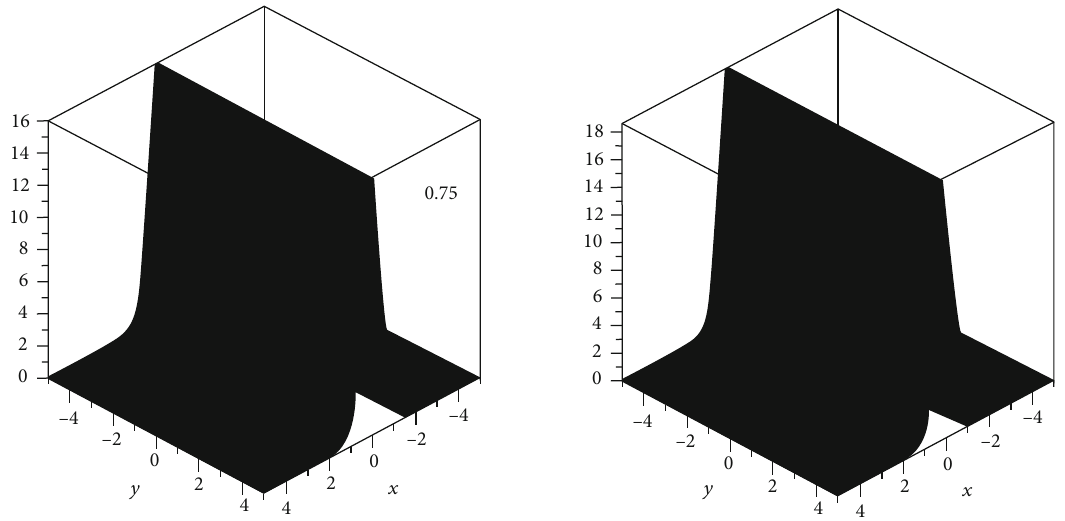
Figure 6: Graphical view of the analytical solution for K ð ζ , ρ Þ at δ = 0 : 8,0 : 6 of system 1 .